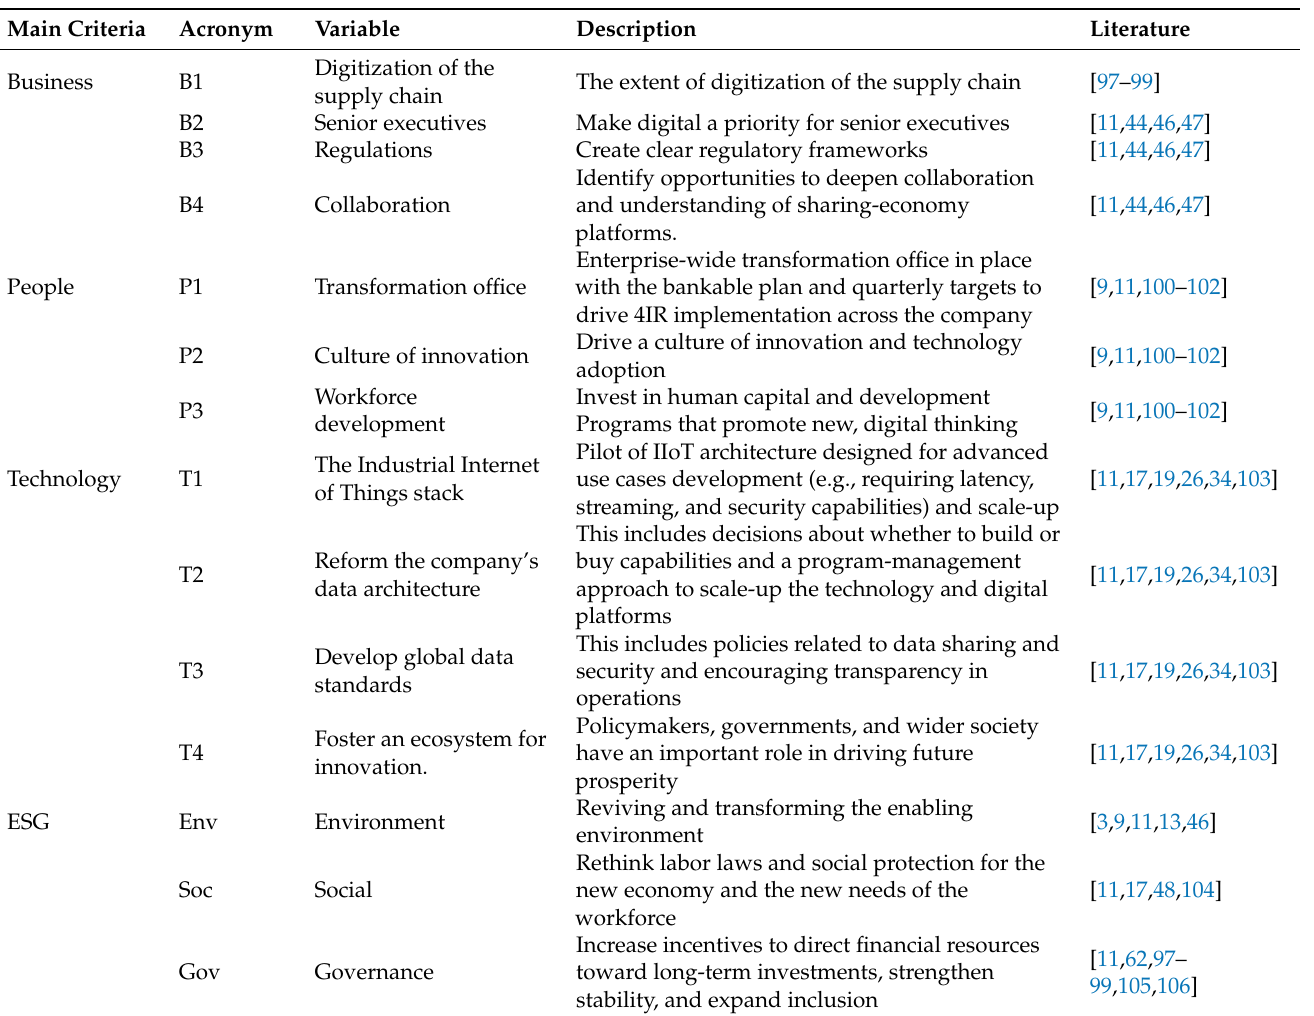
Table A2. The main criteria and variables are key components that help to identify and evaluate the relationships between different factors or phenomena being studied.